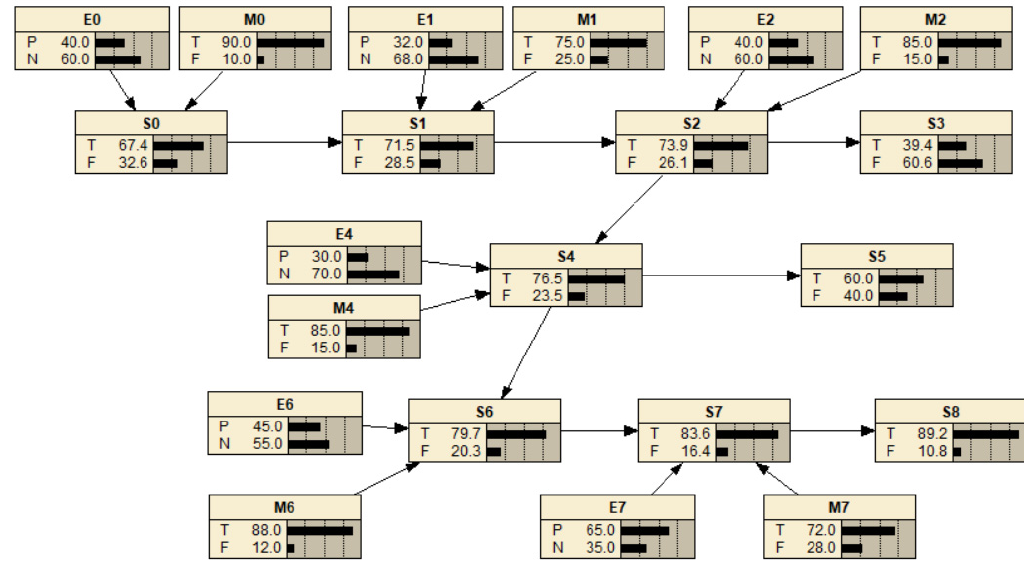
Figure 6. Dynamic scenario evolution network of Xiantao waste NIMBY crisis. (Note: “E” means external situation, “S” means scenario state, “M” means emergency management, “T”means True, “F” means Fales, “P” means “Positive”, and “N“ means “Negative.”).